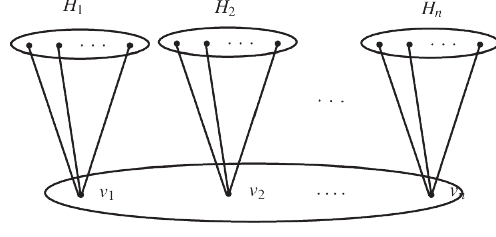
Figure 2. Graph of Coro ( G , H )